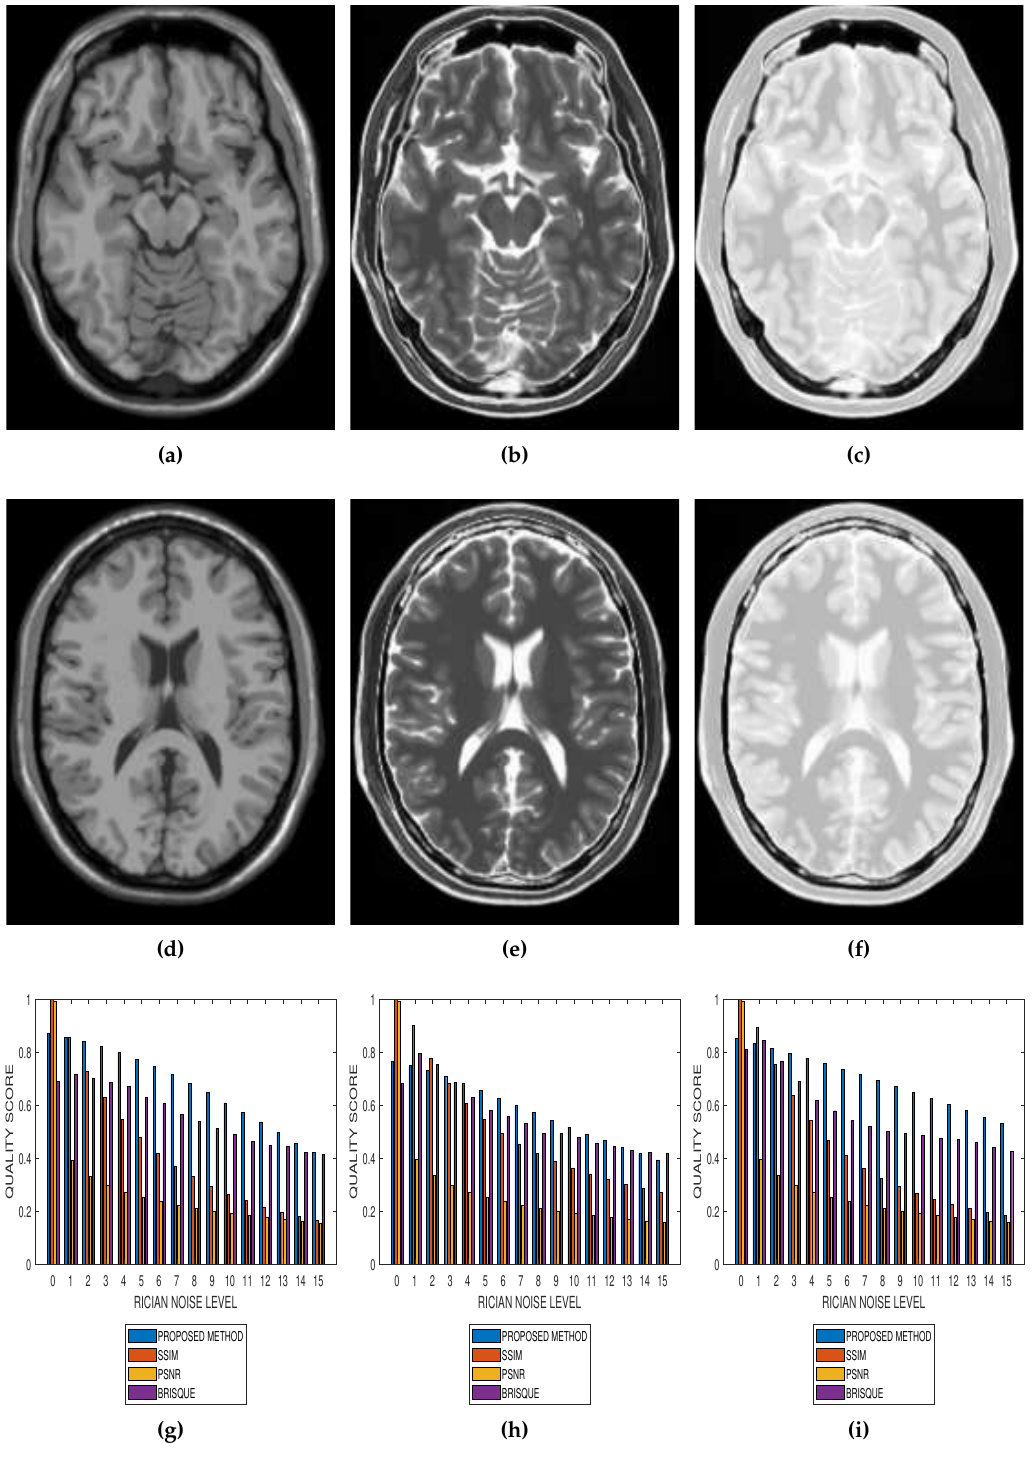
Figure 11. Comparative performance evaluation of the proposed method with SSIM, PSNR and BRISQUE quality metrics using 15 slices in ( a,d ) T1, ( b,e ) T2 and ( c,f ) PD simulated MRI volume data from McGill University BrainWeb ( g – i